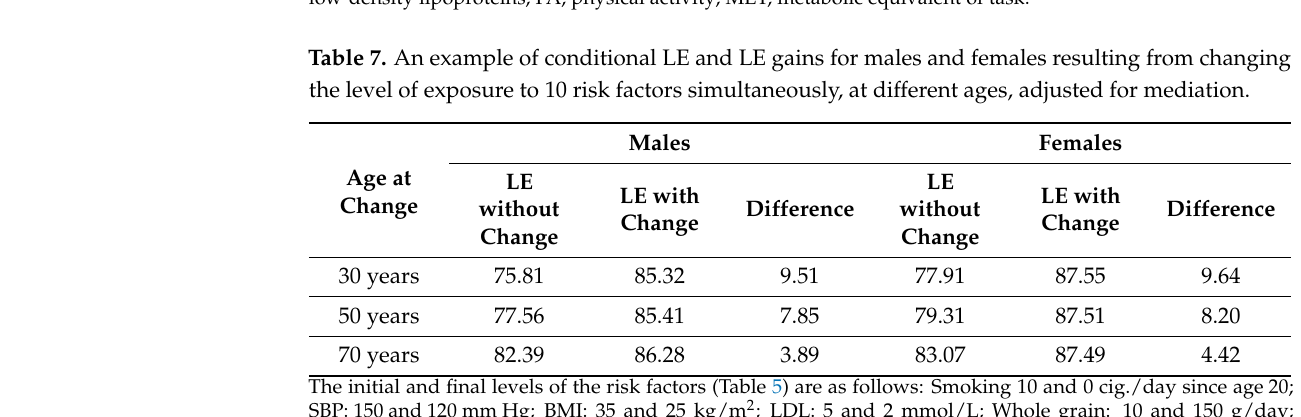
The initial and final levels of the risk factors (Table 5) are as follows: Smoking 10 and 0 cig./day since age 20; SBP: 150 and 120 mm Hg; BMI: 35 and 25 kg/m 2 ; LDL: 5 and 2 mmol/L; Whole grain: 10 and 150 g/day; Fruit: 75 and 300 g/day; Processed meat: 50 and 0 g/day; PA: 600 and 4000 MET-min/week; Alcohol: 42 and 0 g/day; Sodium: 7 and 1 g/day. Data have been obtained from a lagged model. Conditional LE is LE at a